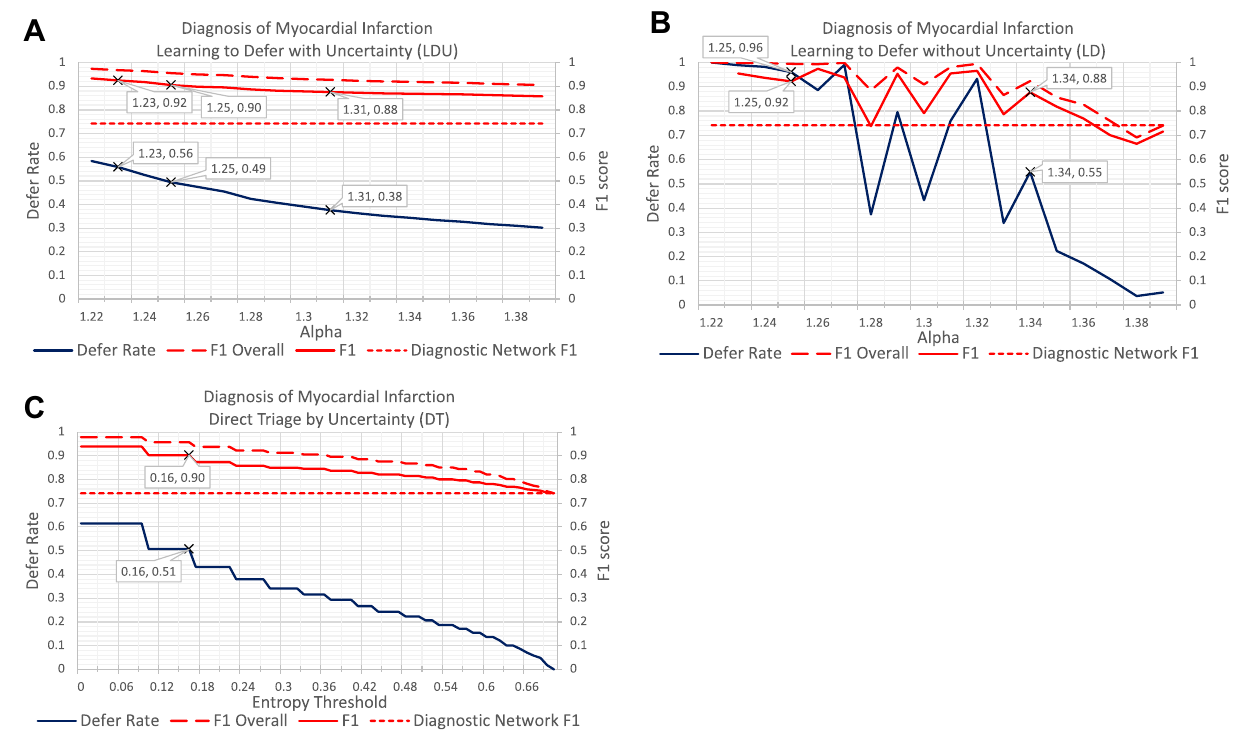
Figure 2. Performance comparison for the diagnosis of myocardial infarction using MIMIC-III discharge summaries and the following algorithms: (A) learning to defer with uncertainty (LDU), (B) learning to defer without uncertainty information (LD), (C) direct triage by uncertainty (DT). Each panel shows the F1 scores (red line) for patients who are not deferred to human experts, ‘F1 Overall’ scores (red dashed line) and the corresponding defer rates (blue line) for different values of the weight of the defer loss α ( A,B ) or of the entropy threshold ( C ). The diagnostic network F1 score (without the defer option) is 0.74 (red dotted